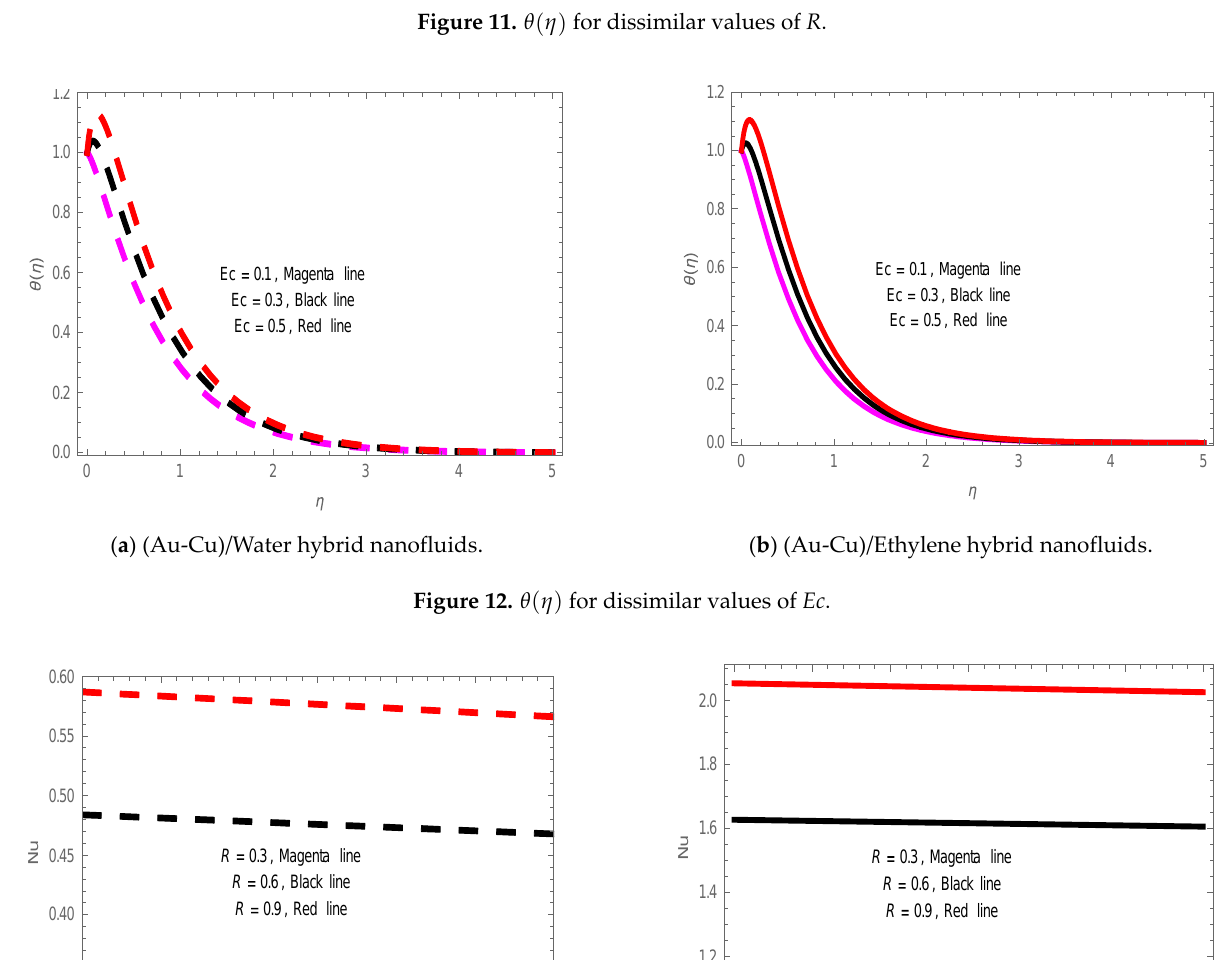
Figure 11. 𝜃(𝜂) for dissimilar values of R .